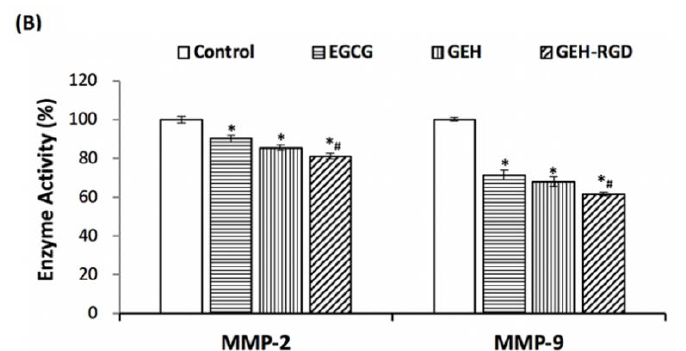
Figure 3. EGCG NPs inhibit activity of MMPs in endothelial cells. ( A ) Results of gelatin zymography from culture medium after 24 h incubation with a variant formulation for confirm the MMPs activity. ( B ) Quantification of MMP-2 and MMP-9 activities compared with the control group ( n = 3). * p < 0.05 compared with control, # p < 0.05 compared with EGCG. Abbreviation: EGCG: epigallocatechin-3 gallate, HA: hyaluronic acid, RGD: arginine-glycine-aspartic acid, GE: Gelatin / EGCG self-assembling nanoparticles (NPs), GEH: GE NPs with HA surface coating, GEH-RGD: GE NPs with HA-RGD surface decoration, MMP: metalloproteinase.